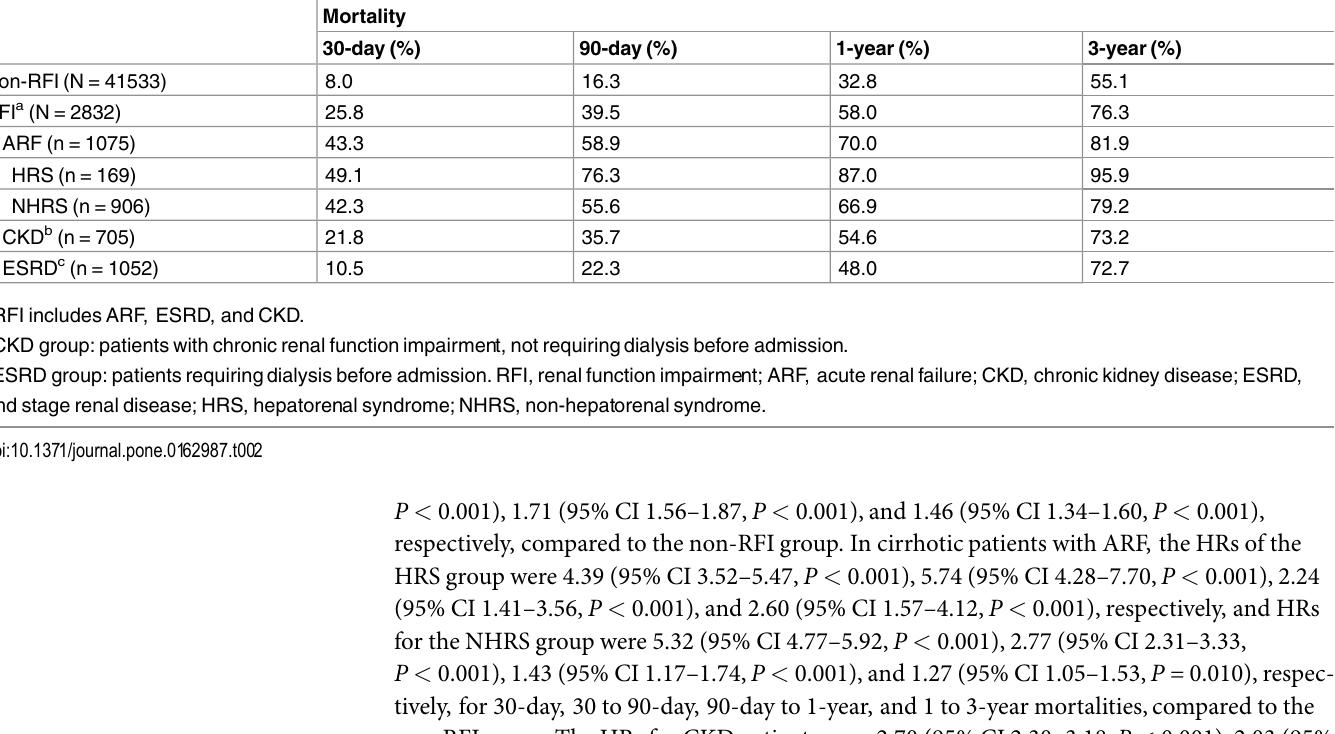
Table 2. The 30-day, 90-day, 1-year, and 3-year mortality of cirrhoticpatients withdifferent typesof renal functionimpairment.